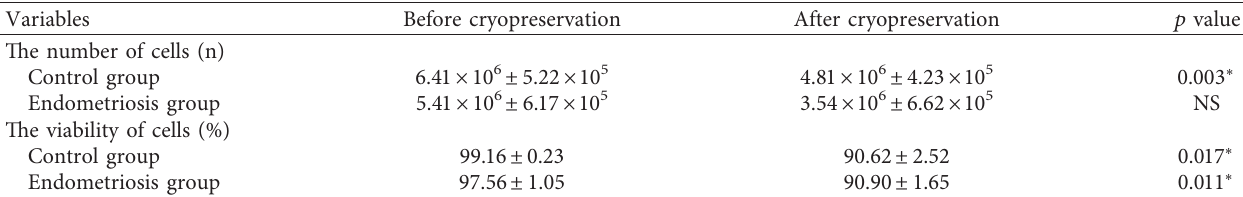
Table 1: The number and viability of cells before and after cryopreservation in endometriosis and control groups.